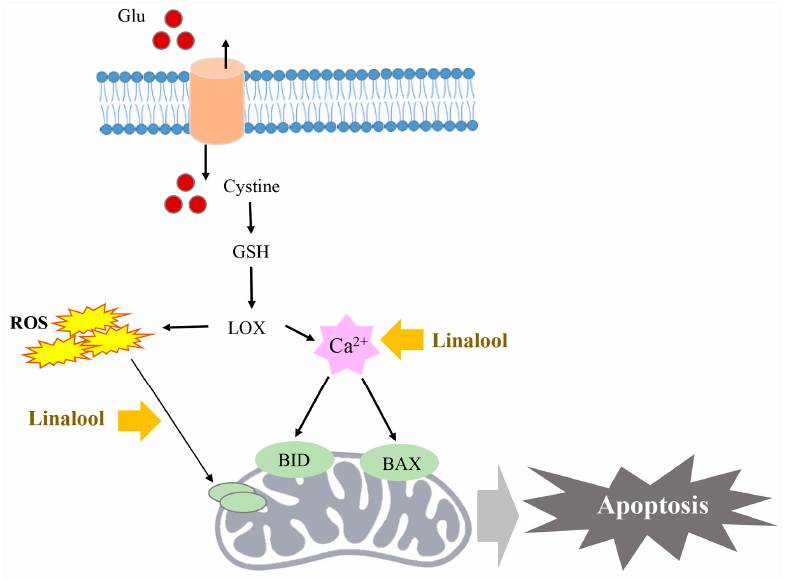
Figure 7. Linalool decreases oxidative stress-induced cell death by regulating glutamate metabolism in the hippocampus (modified from Sabogal-Guaqueta et al. 2019 [27]). In several neurological conditions such as Alzheimer’s disease and neuroinflammation, glutamate induces cysteine influx into the cytoplasm and stimulates oxidative stress, thus inducing apoptosis. Linalool prevents ROS generation and Ca 2+ activation in the mitochondria in the cornu ammonis 1 and 3 and dentate gyrus in the hippocampal regions of the brain.